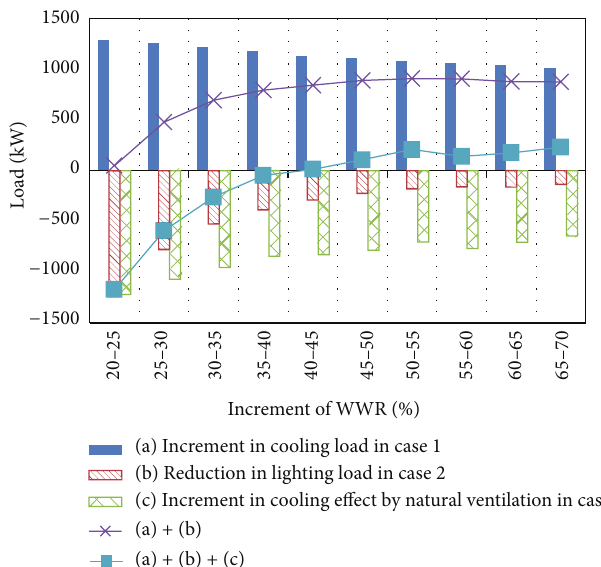
Figure 9: Influence of window